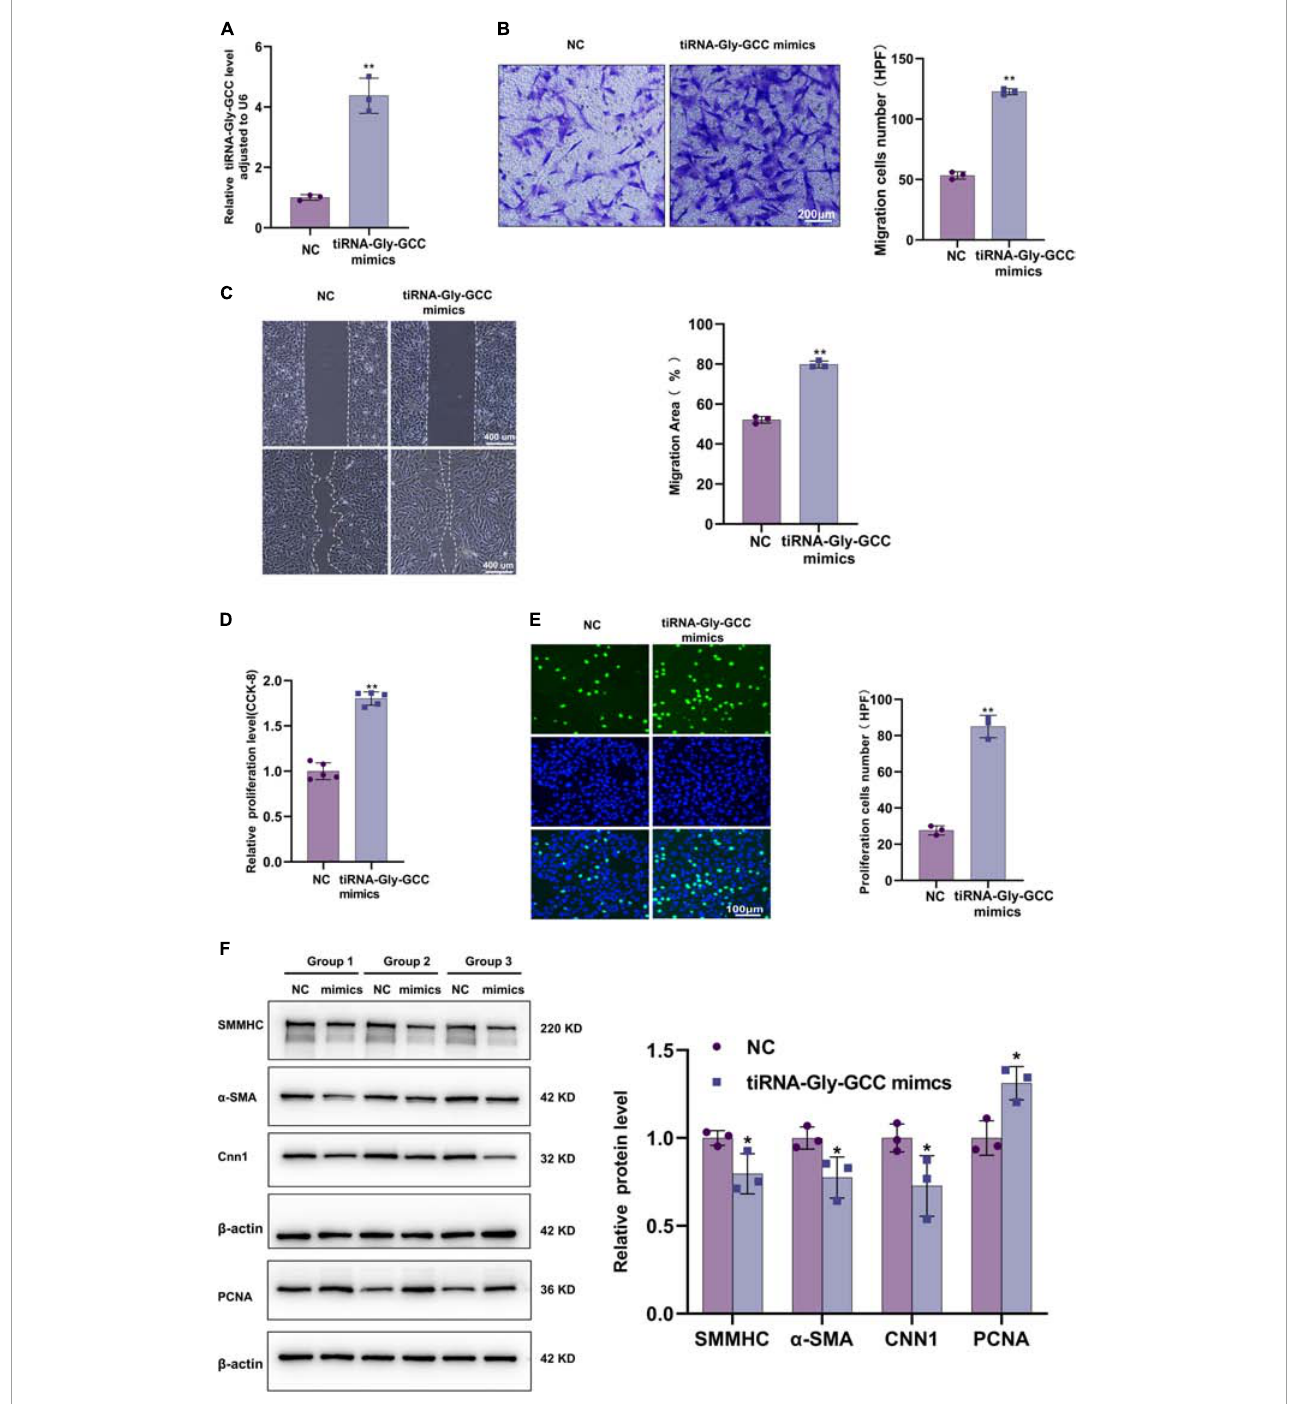
FIGURE4 Overexpression of tiRNA-Gly-GCC promoted HASMCs proliferation, migration, and dedifferentiation. (A) qRT-PCR confirmed the overexpression efficiency of tiRNA-Gly-GCC mimics in HASMCs compared with negative control (NC), and data were normalized to U6. Data are presented as the mean ± SD. n = 3, **p < 0.01. (B) Transwell assays demonstrated that the overexpression of tiRNA-Gly-GCC promoted HASMCs migration. The left panel refers to representative image of Transwell assays and the right panel refers to quantification results of migrated HASMCs, from three